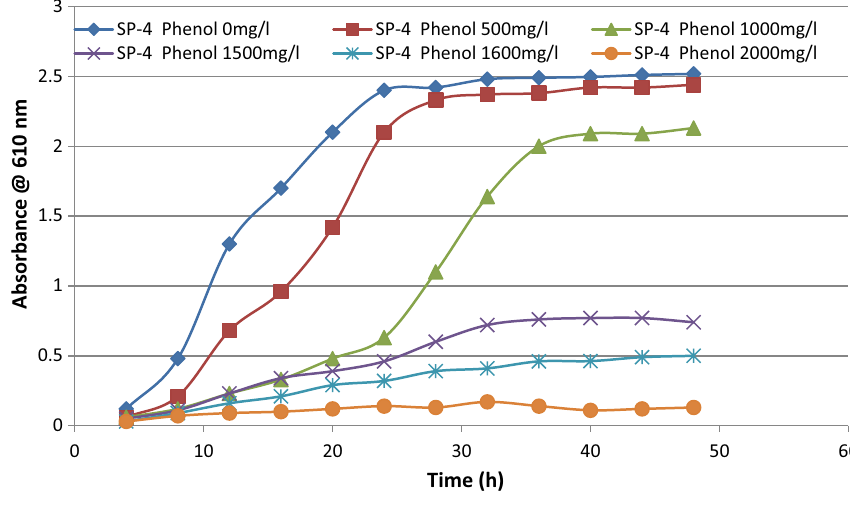
Fig. 2 Growth study of SP-4 at different concentrations of phenol (0–2000